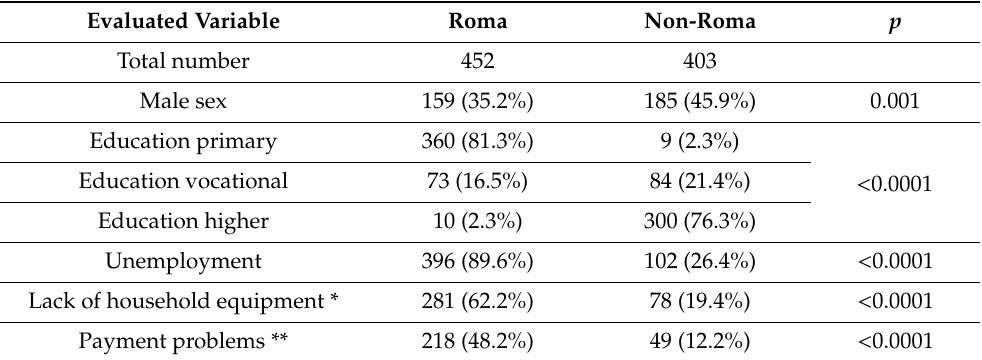
Table 1. Characteristics of the Roma and non-Roma population in the HepaMeta study.